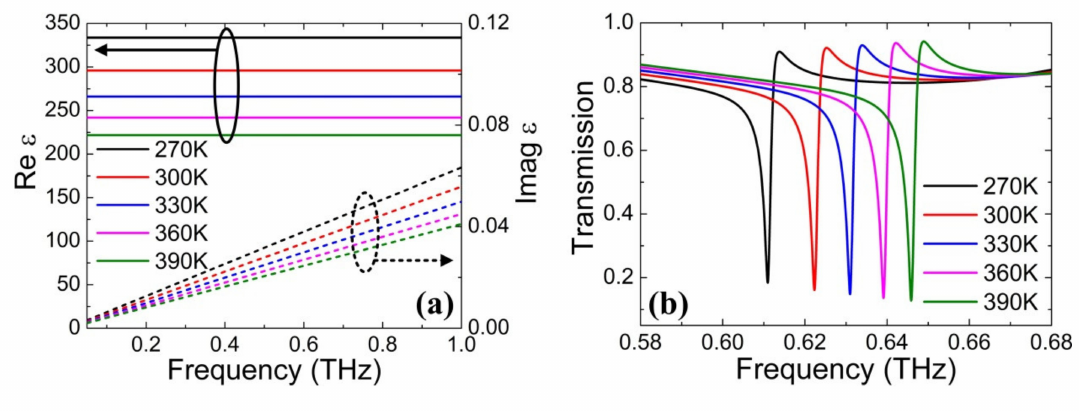
Figure 5. ( a ) Real and imaginary part of STO permittivity at di ff erent temperatures. ( b ) Transmission spectra of the proposed metasurface structure under di ff erent temperatures of the STO film, where the Fermi level of the graphene monolayer is fixed as 0